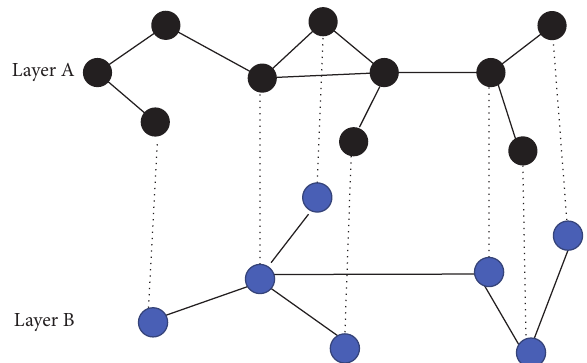
Figure 1: Coupled network